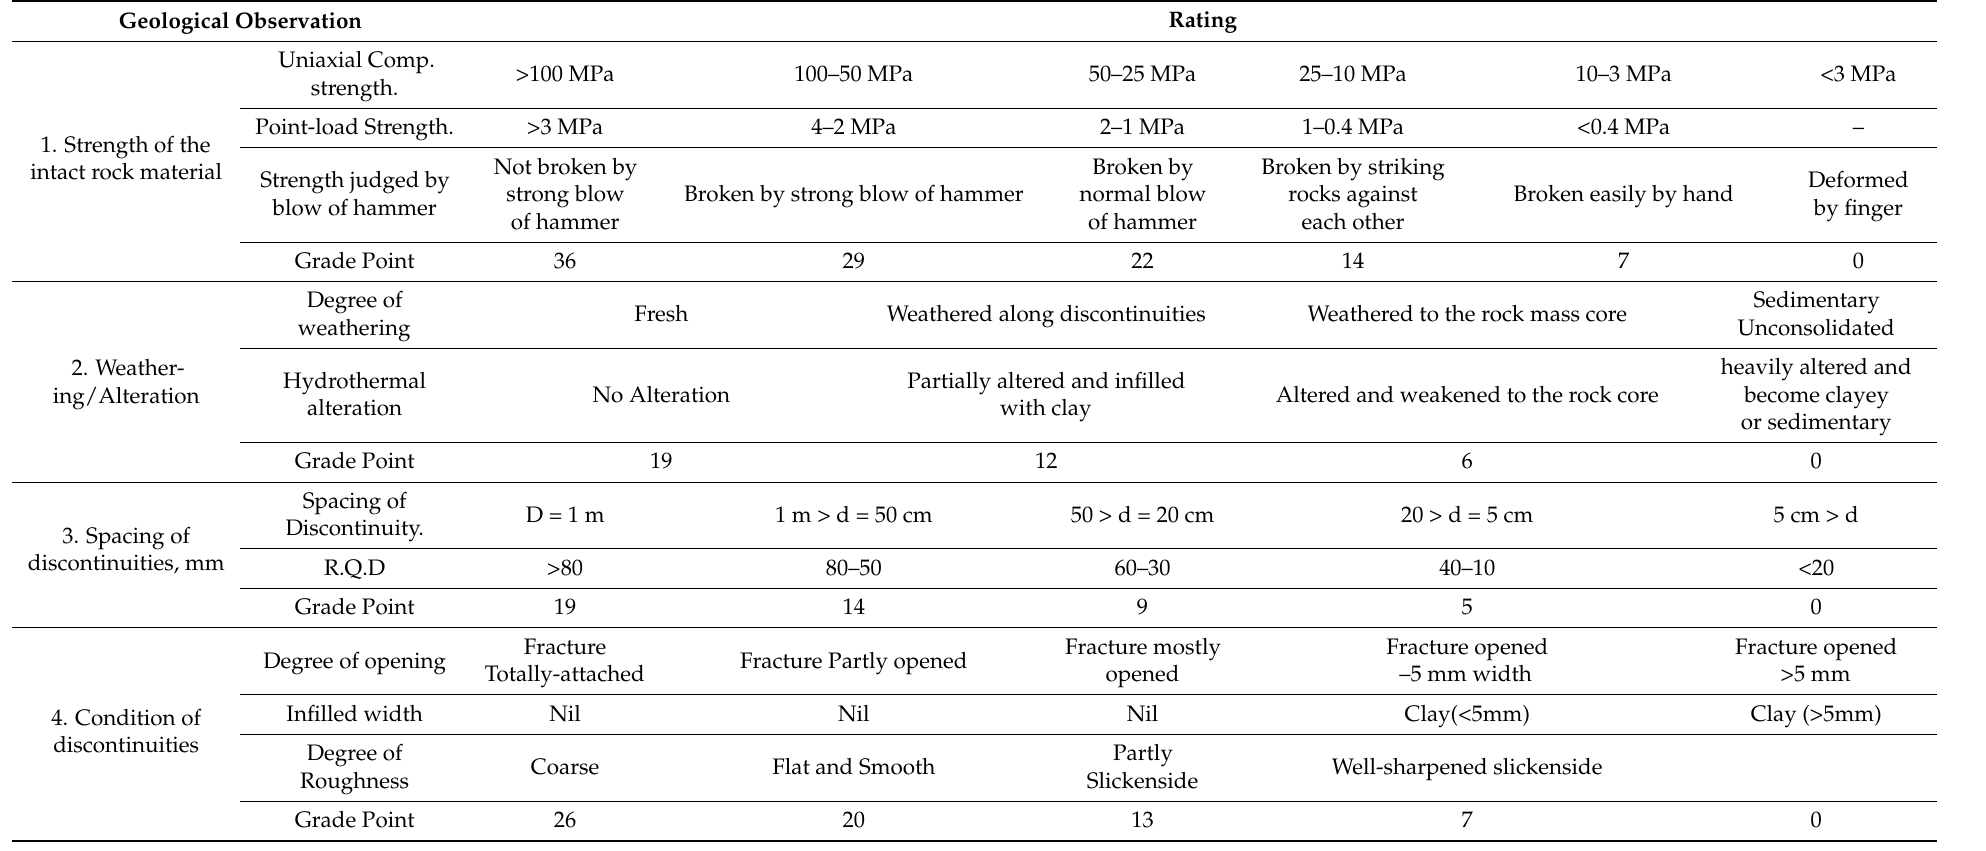
Table 1. Example of the JH System Data Collection Sheet Used in the PSRWT